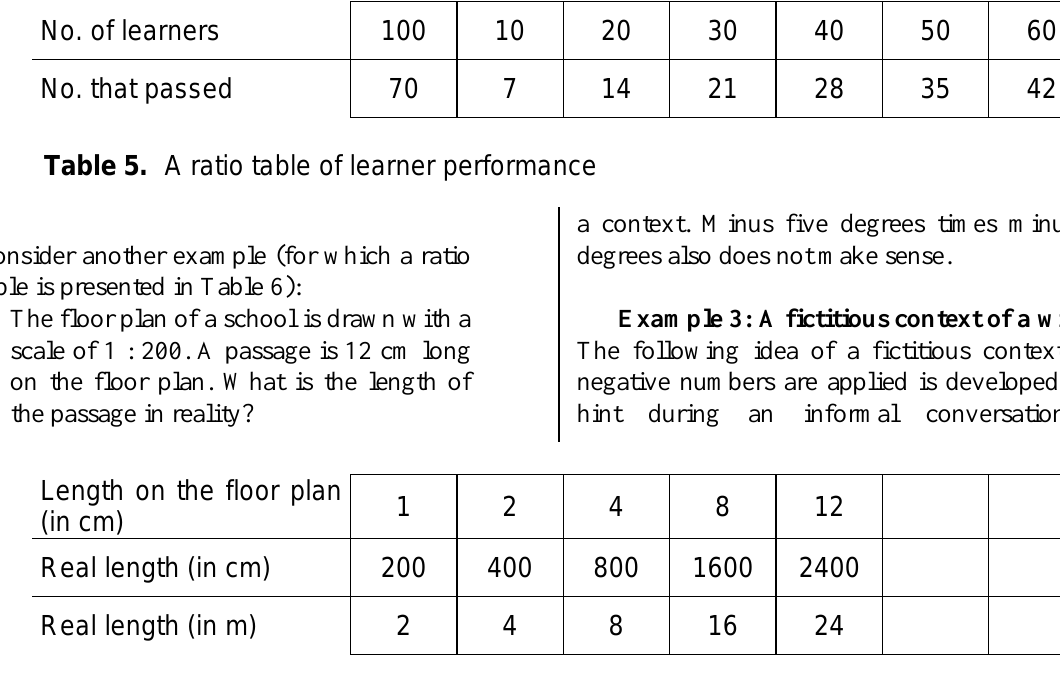
Table 6. A ratio table of length of a